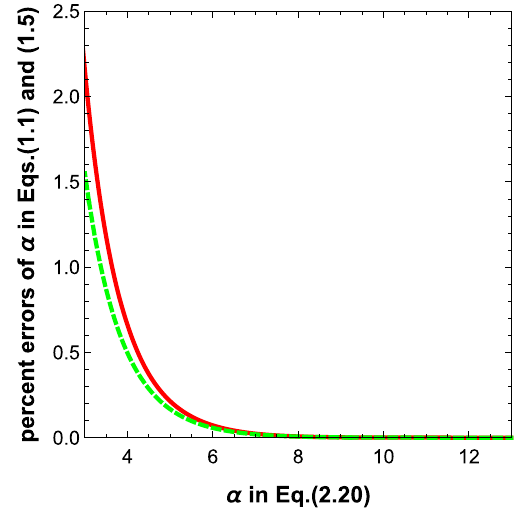
Fig. 2 The percent errors of deflection angles in the Ellis–Bronnikov wormhole spacetime. Solid (red) and dashed (green) curves denote the percent errors of the deflection angles in Eqs. (1.1) and (1.5), respec- tively, against the deflection angle in Eq.